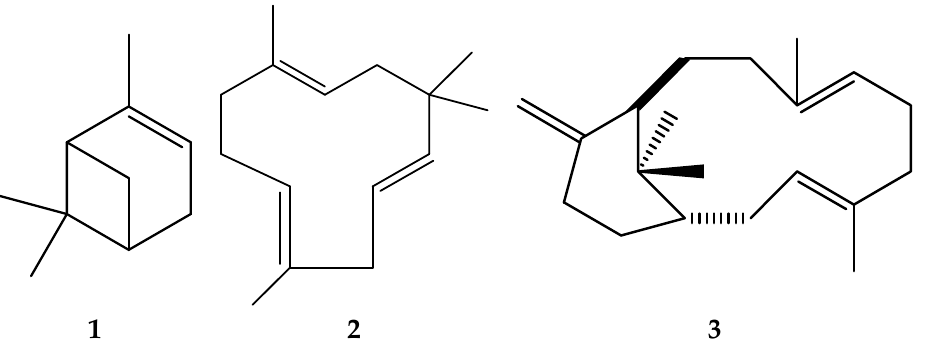
Figure 1. Chemical structure of β -Pinene ( 1 ), humulene ( 2 ) and (1 S ,3 E ,7E,11 R )-(+)-verticilla-3,7,12(18)-triene ( 3 ). ( 3 ) from the essential oils of C. gileadensis .